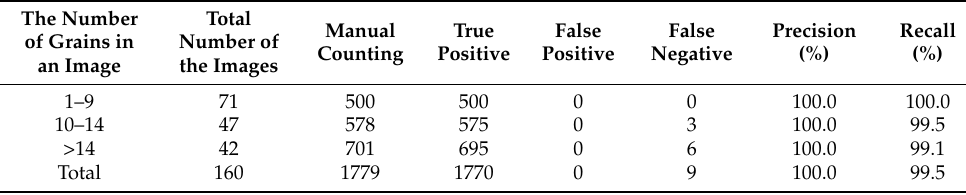
Table 5. The detection results of images with different numbers of grains.